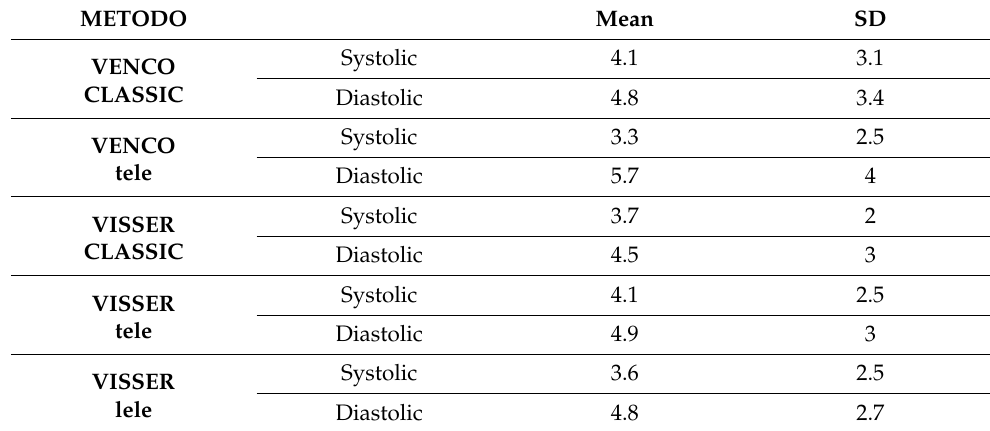
Table 5. Coefficients of variation. Data expressed as mean and standard deviation (SD).